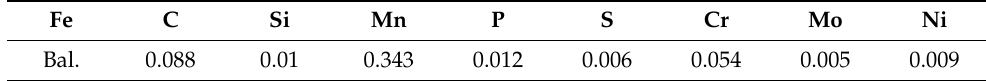
Table 1. Chemical composition of the 1.031 unalloyed steel substrate (wt.%). Fe C Si Mn P S